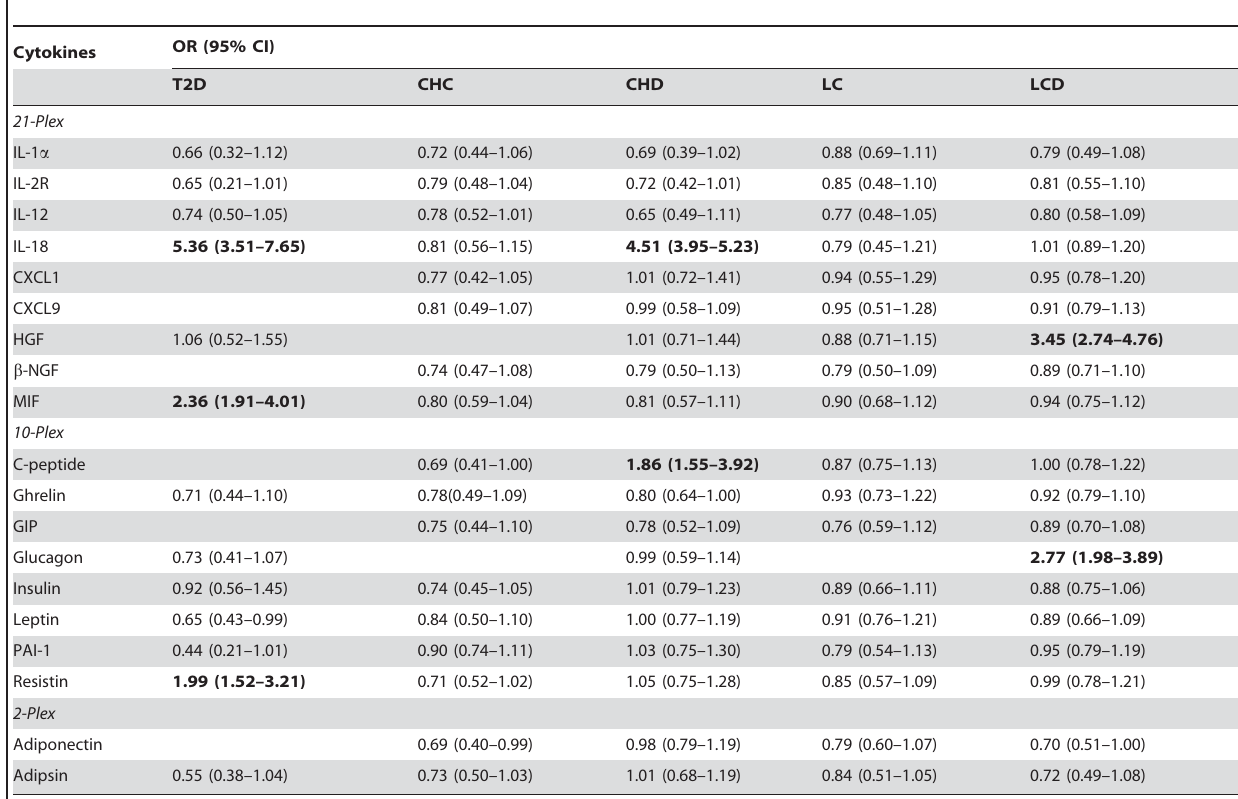
Table 4. Multivariate regression analysis using the cytokines as dependent variables and smoking status, hypertension, BMI, and hypercholesterolemia as independent